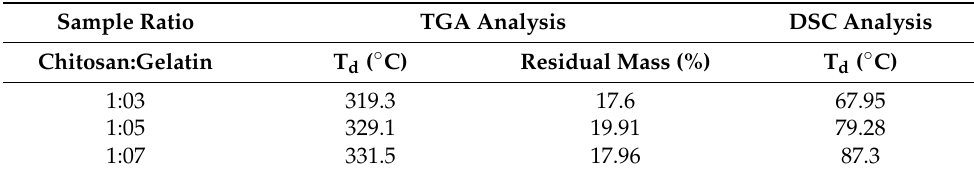
Figure 6. ( a ) Thermogravimetric analysis (TGA) and ( b ) derivative thermogravimetry (DTG) curves of the modified membrane foam in the chitosan:gelatin composition ratios of 1:3, 1:5, and 1:7. Table 1. Degradation temperature and mass residual percentage of the modified membrane foam at chitosan:gelatin composition ratios of 1:3, 1:5, and 1:7 during the TGA and DSC